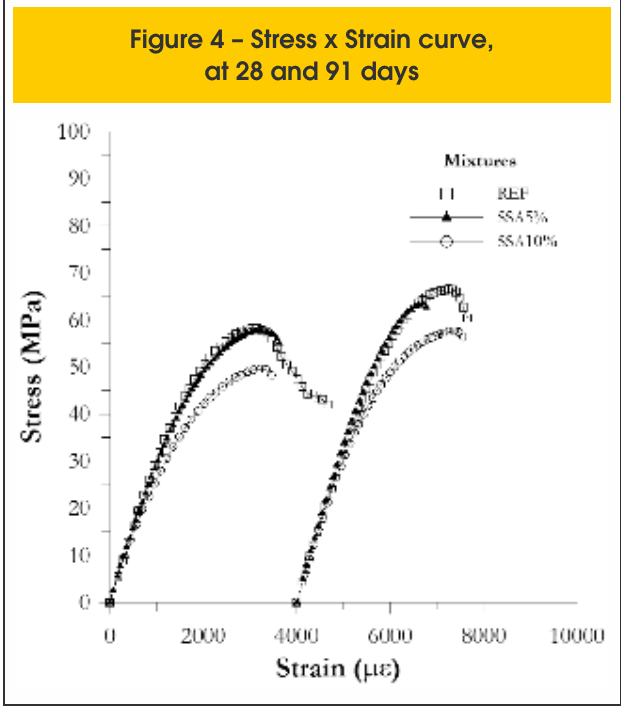
Figure 4 – Stress x Strain curve, at 28 and 91 days